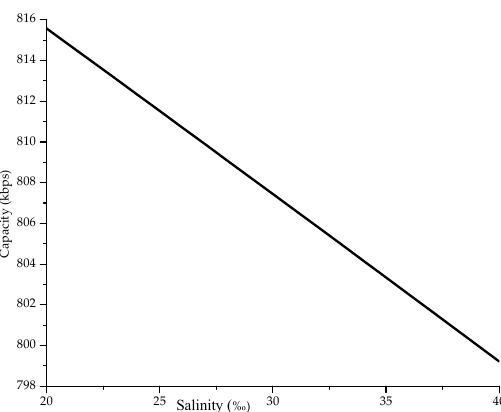
Figure 4. Average capacity for different values of salinity.